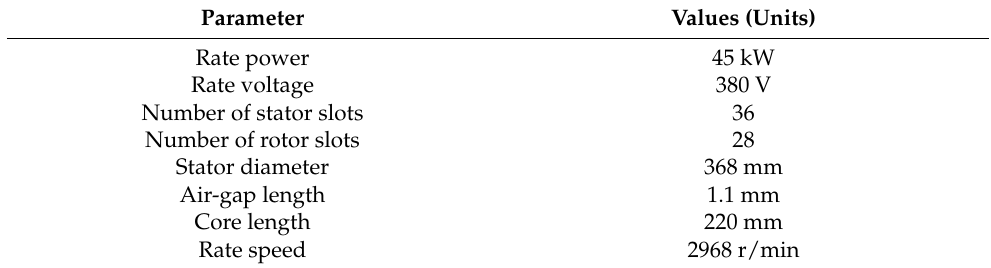
Table 4. Prototype parameters.